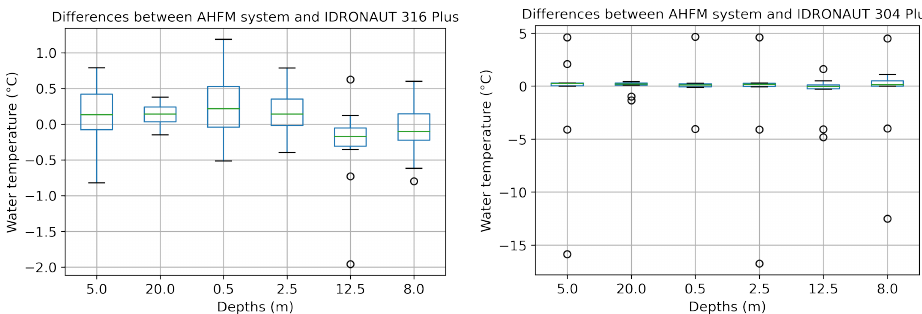
Figure 21. Comparison of water temperatures between AHFM and manual sampling with IDRO- NAUT